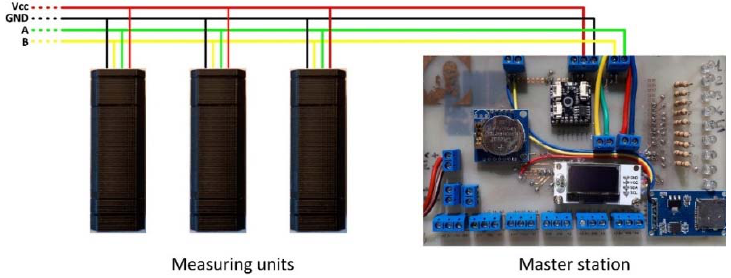
Figure 7. Wiring scheme for connecting the measuring units and the master station.